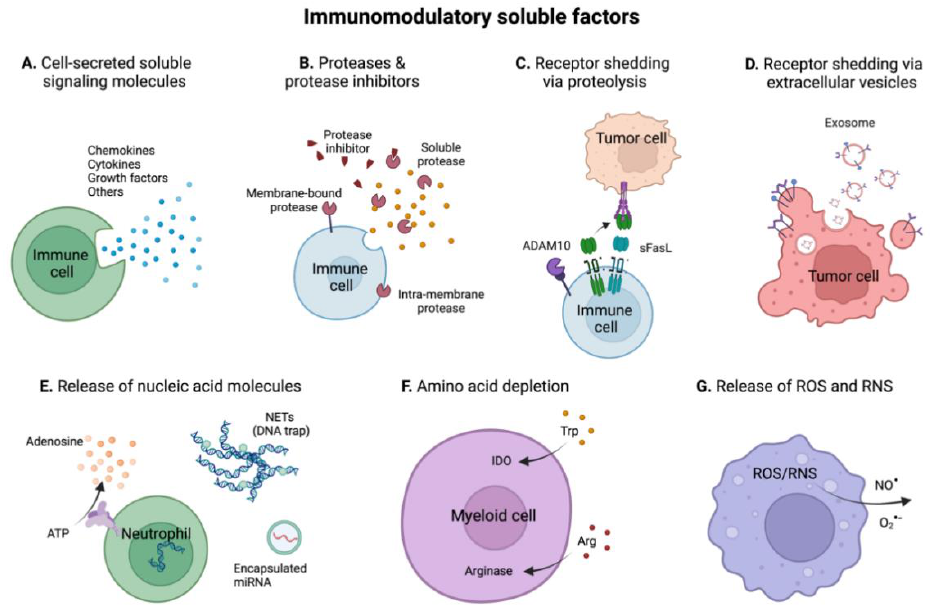
Figure 5. Cell-secreting soluble factors as potent immunomodulatory molecules in the TME. ( A ) Cell secretion of potent immunomodulatory signaling proteins (e.g., chemokines and cytokines). ( B ) Immune regulation via the secretion of protease and protease inhibitors. ( C ) Proteolytic release of cell surface-bound immunomodulatory receptors or factors. ( D ) Receptor shedding in the TME by exosomes or other EVs. ( E ) Immunomodulation via the presence of nucleic acid in the TME (e.g., ATP, adenosine, miRNA, NETs). ( F ) Depletion of amino acids from the TME by amino-acid degrading enzymes (e.g., IDO, arginase). Amino acids are essential to some immune cells’ functions. ( G ) Release of ROS and RNS upon cellular stress. ROS and RNS react and damage DNA, proteins, lipids and glycans, thereby positively or negatively affecting immune responses.